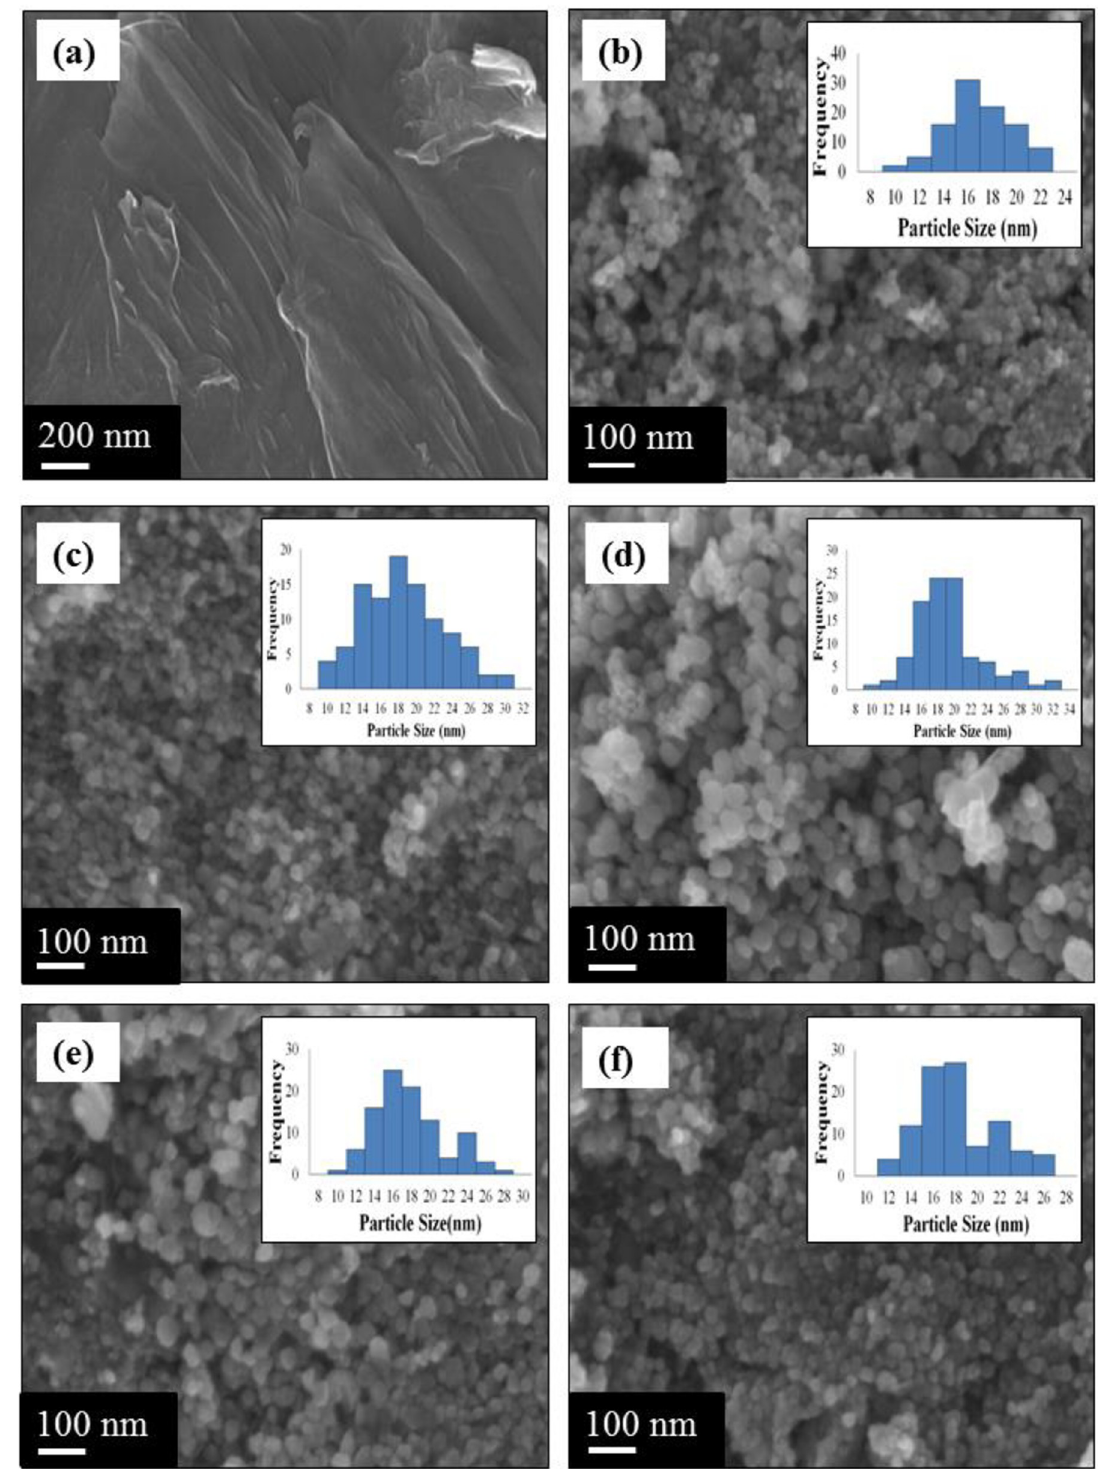
Fig 1. FESEM image of (a) GO. FESEM images and particle size histogram (inset) of (b) M-rGO3, (c) M-rGO6, (d) M-rGO12, (e) M- rGO18 and (f) M-rGO24.